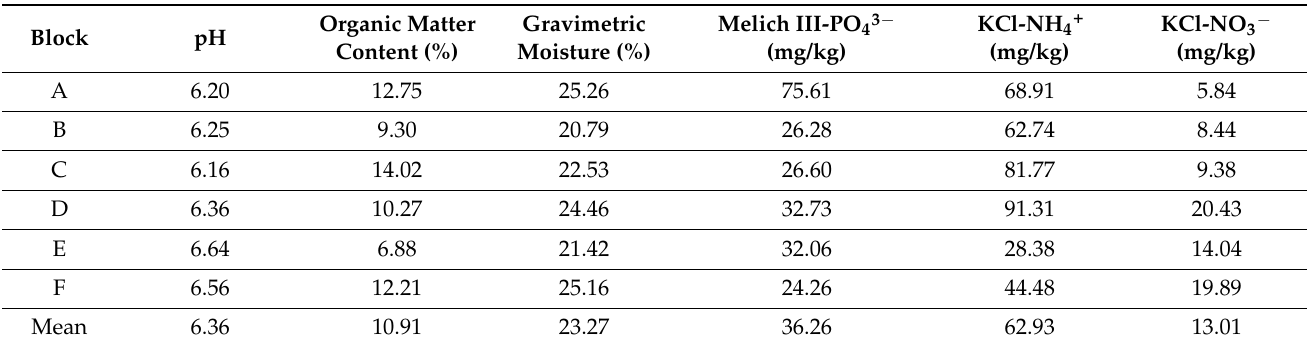
Table 1. Soil properties were measured on composite samples taken from each experimental block. Mehlich- III-PO 43 − = orthophosphates extractible with Mehlich-III solution; KCl-NH 4+ and KCl-NO 3 − are, respectively, ammonium and nitrates extractible using 2N